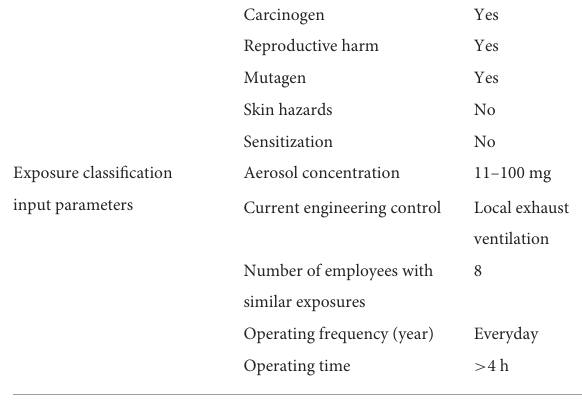
FIGURE1 Locations of monitoring sites. •: Detection point.